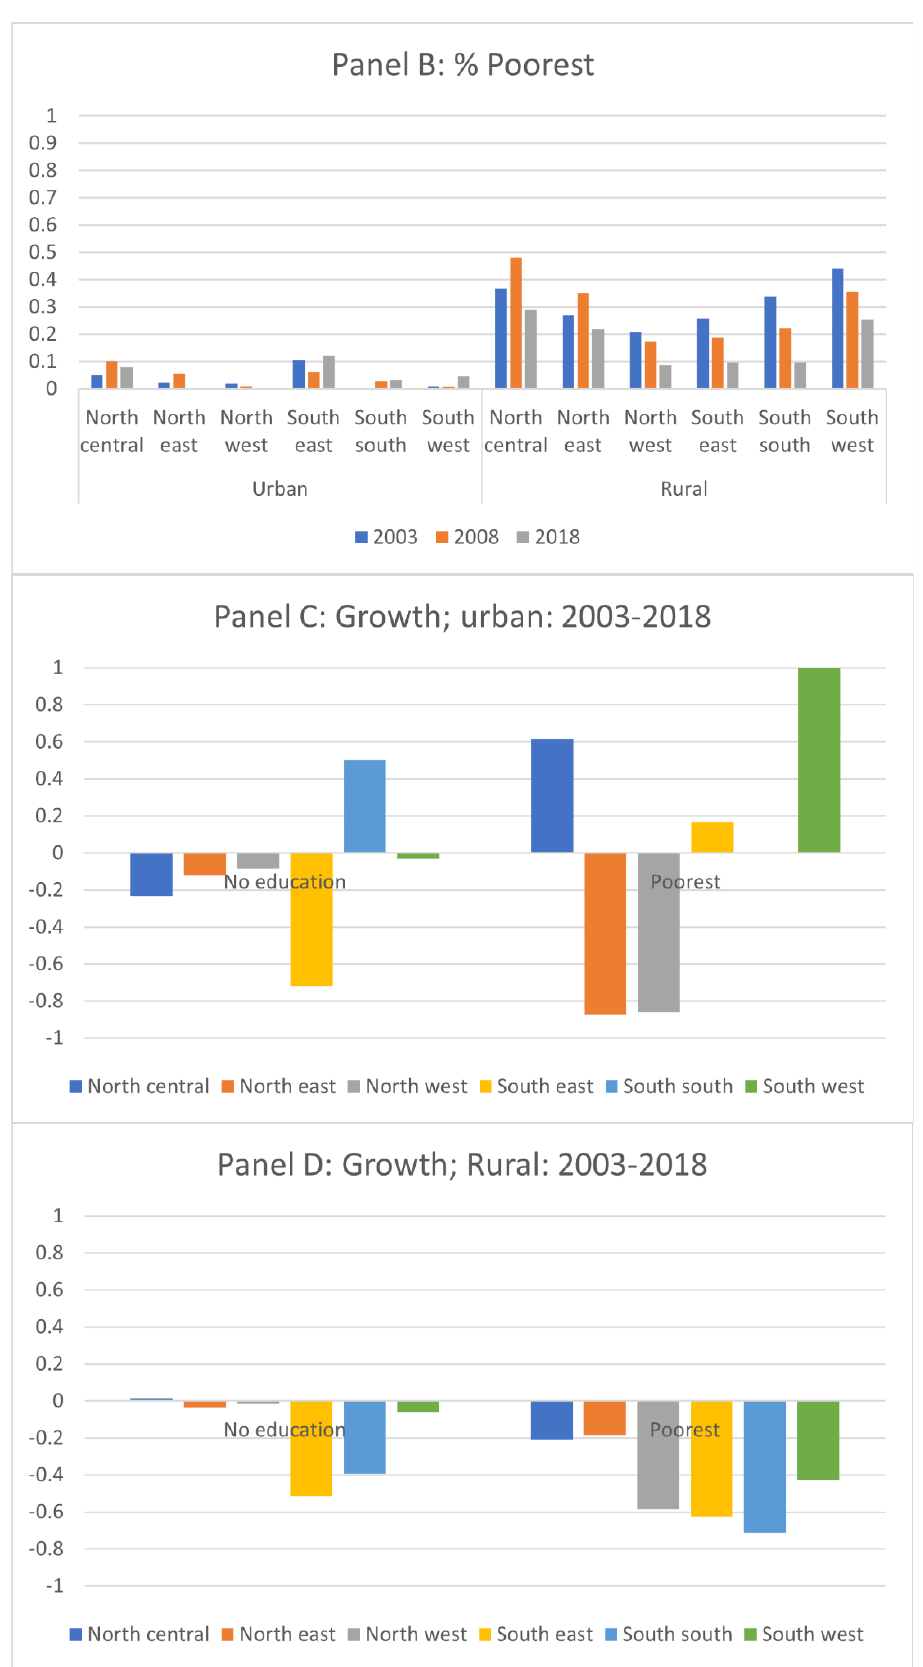
Figure 3. Trend of proportions of mothers with no educational attainment and of households in the poorest quintile over time by zone.